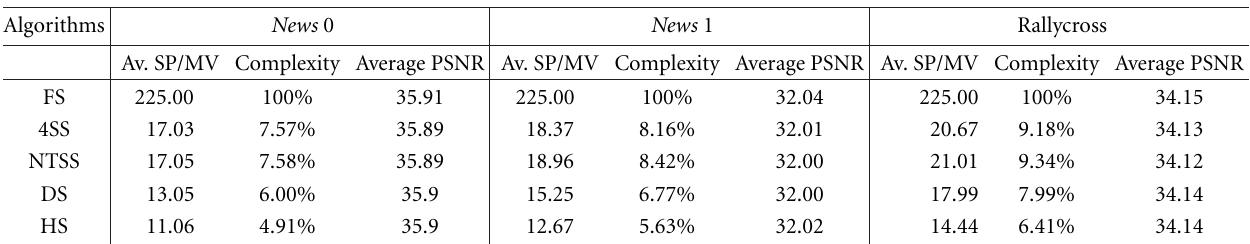
Table 1: Average search points (SP) per motion vector (MV) estimation and PSNR for the first 100 frames. Algorithms